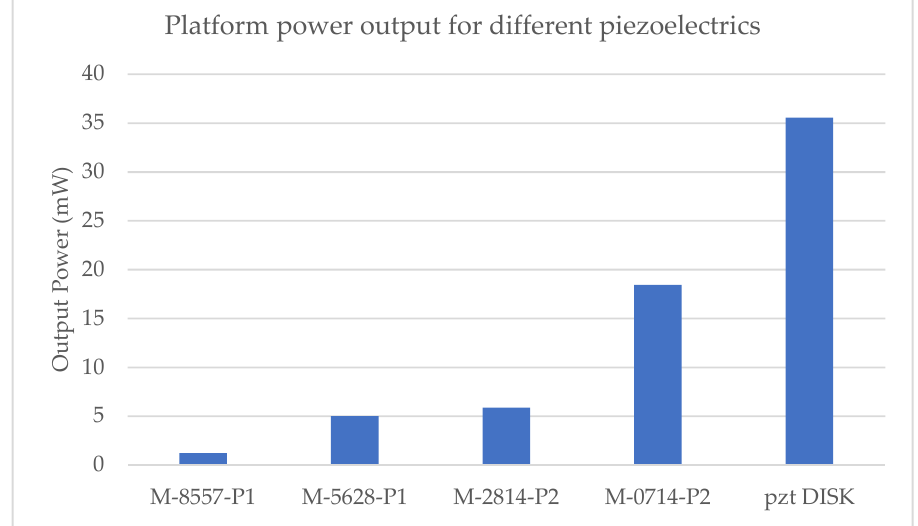
Figure 4. Output power of the platform for different piezoelectric transducers arrangement.